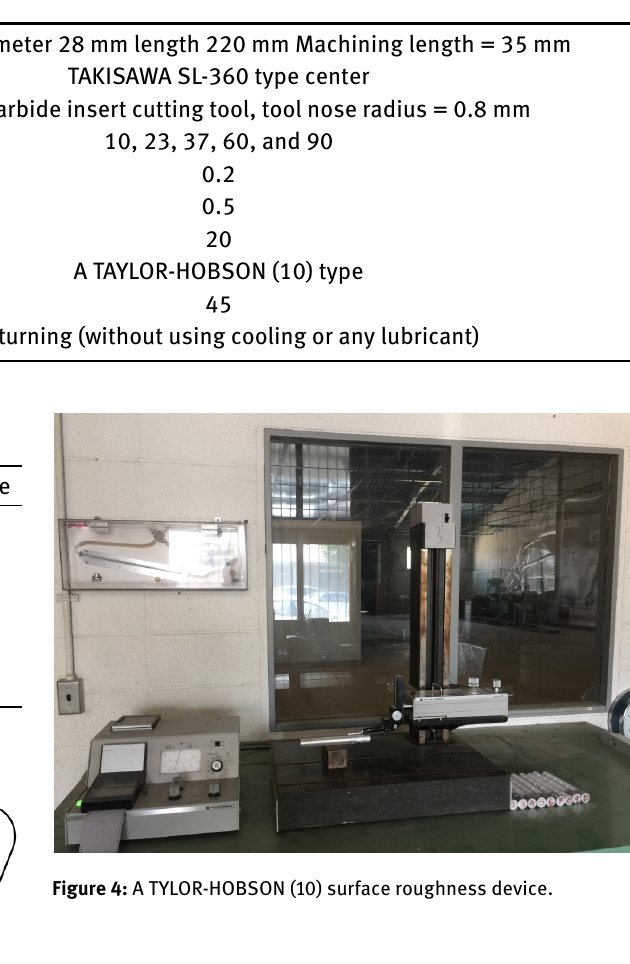
Table 7: Experimental conditions summary.